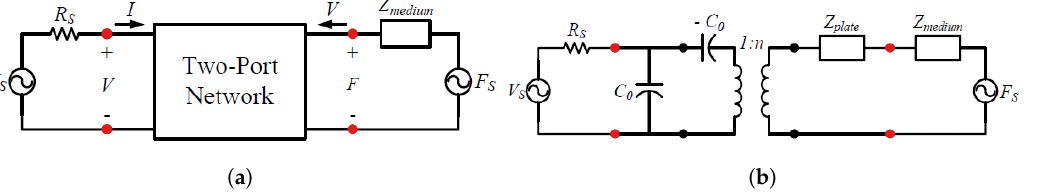
Figure 3. CMUT Network model. ( a ) General two-port network representation that relates voltage and current ( V and I ) to force and velocity ( F and V ). ( b ) Small-signal equivalent circuit model (in transmit mode, F s = 0, and in receive mode, V s = 0). R s represents the electric source